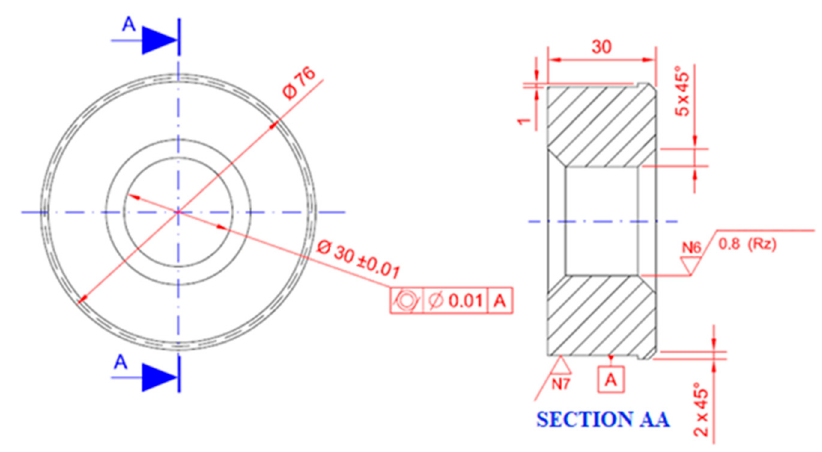
Figure 2. The specimen dimensions.